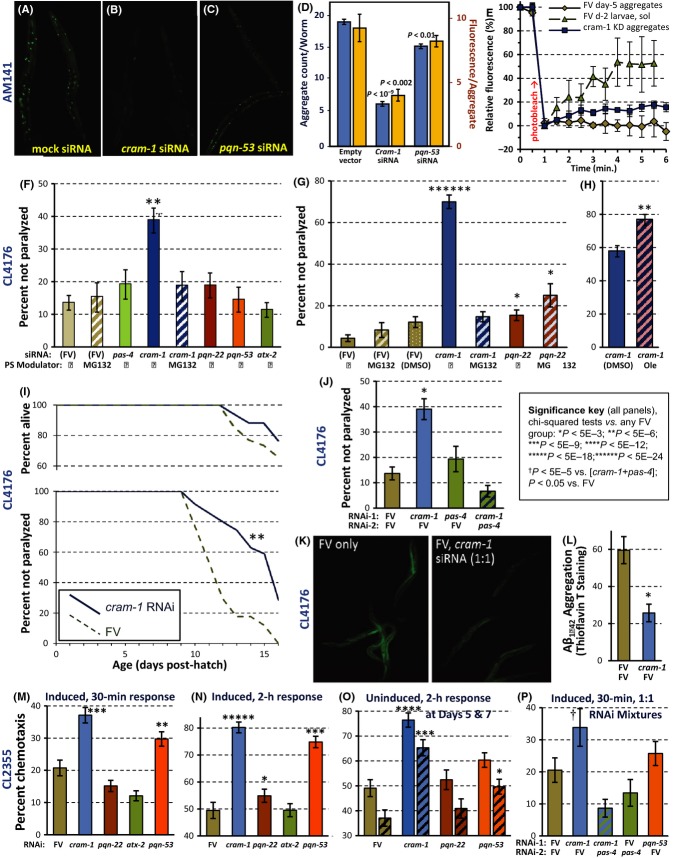
Aggregates and associated traits are lessened by RNAi. (A–D) For 3 days from the L4/adult molt, worms were fed E. coli with empty vector (FV) or expressing dsRNA targeting cram-1 or pqn-53. Worms were imaged on 5 dPH (adult day 2.5). (A–C), fluorescence images; (D) aggregate count (blue bars, left scale) and intensity/aggregate (orange bars, right scale), ± SEM, for N = 12–14 worms/group. Each knockdown was compared to control by two-tailed t-tests. (E) Fluorescence recovery after photobleaching was assessed as described (van Ham et al., 2009). For times ≥ 4 min, each group differed from either other group by two-tailed t-test, P < 2E-6. (F) CL4176 worms were exposed to RNAi or MG132 from the L3/L4 molt; myo-3p/Aß1–42 was induced 48 h later by upshift to 25 °C, assaying paralysis 32 h later. (G, H), paralysis 28 h postinduction, as (F) except treatments began at hatching, with Aß1–42 induced 48 h later. (F–H), MG132 was added at 20 μm, oleuropein (Ole) at 80 μg mL−1; N > 150/group. (I) Uninduced CL4176 (at 20 °C) undergo age-dependent paralysis, delayed ∼30% by cram-1 RNAi fed from the L4/adult molt (P < 10−6; N = 34–35/group). (J) CL4176 worms, fed dual RNAi from early L4, had Aß1–42 induced at 48 h; paralysis and amyloid were measured 32 h later. The cram-1/FV RNAi mix (blue bar) reduced paralysis below other groups (each P < 0.001); in two repeats, each P < 0.05, 0.002. (K) CL4176 adults were stained with thioflavin T (ThT) after 3 days on FV or a 1:1 mixture of FV and cram-1 RNAi. (L) ß-amyloid staining with ThT fell ∼60% with cram-1 RNAi (P < 0.001, one-tailed t-test). (M) Impaired chemotaxis to n-butanol, in CL2355 worms expressing pan-neuronal Aß1–42. Induced worms (M, N, P), RNAi-treated from the L3/L4 molt, were upshifted 48 h later. Chemotaxis (%) was scored after 0.5 or 2 h. Uninduced worms (O) were fed RNAi from hatch. Chemotaxis declined between d5 (solid bars) and d7 (hatched bars). (P) Worms were fed dual RNAi bacteria (1:1) as indicated. (F–H, J, M–P) Error bars show standard errors of proportions. Key and legend: unadjusted chi-squared P values are shown, N = 50–200/group. Similar results were obtained in repeats for each panel.